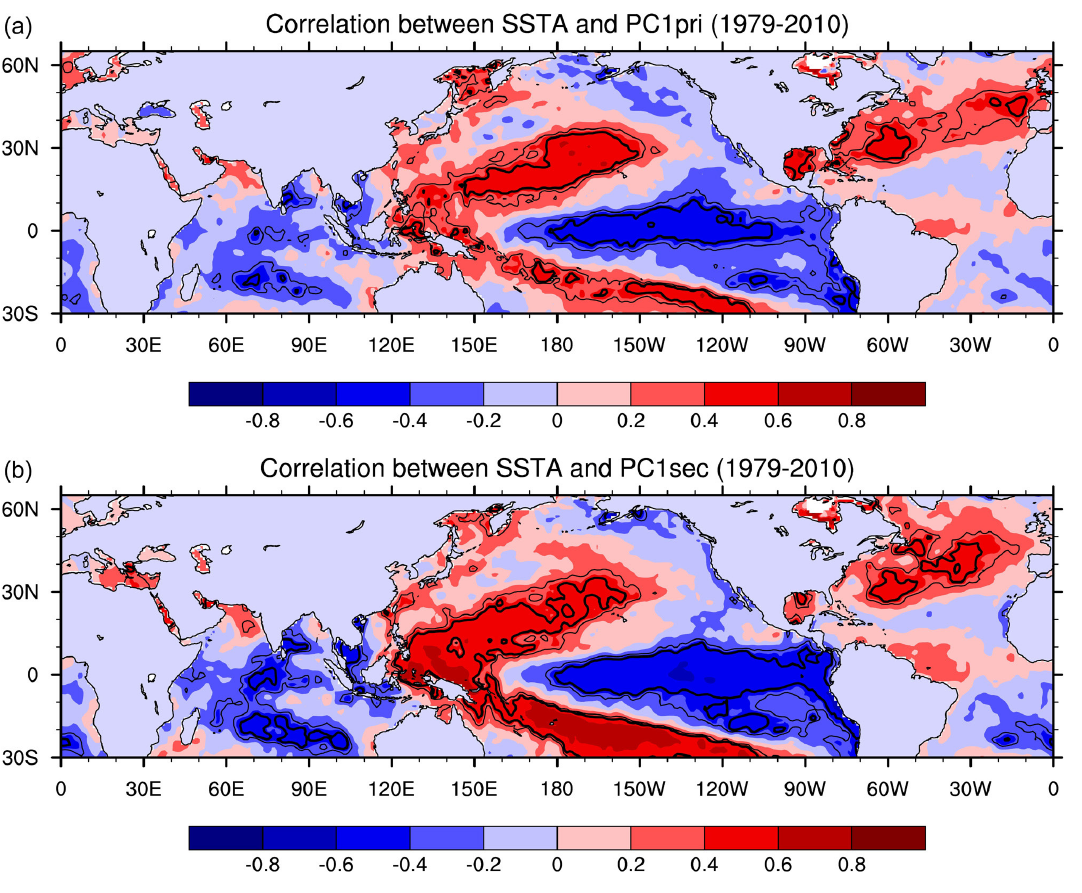
Figure 6. Correlation maps between ( a ) the primary part of the leading principal component (PC1pri) to sea surface temperature anomalies; ( b ) is the same as (a), but for the secondary component (PC1sec). Shading presents correlation coefficients, and the thick and thin contour lines denote the significance levels at 0.01 and 0.05, respectively. SSTA, sea surface temperature